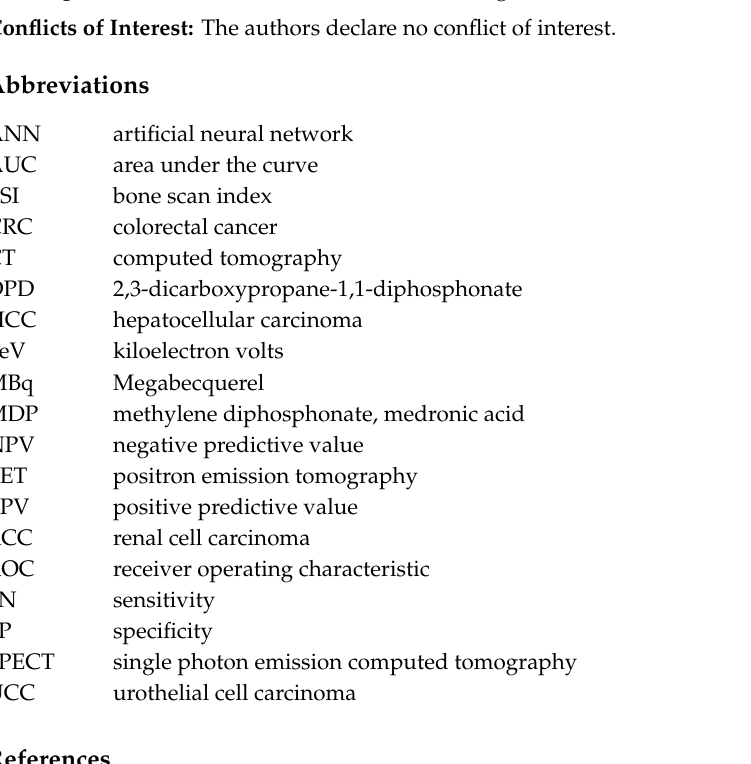
Table S1: E ff ect of the information bias from physician’s report (e.g., from added SPECT / (CT)) on performance of BSI for di ff erent tumor